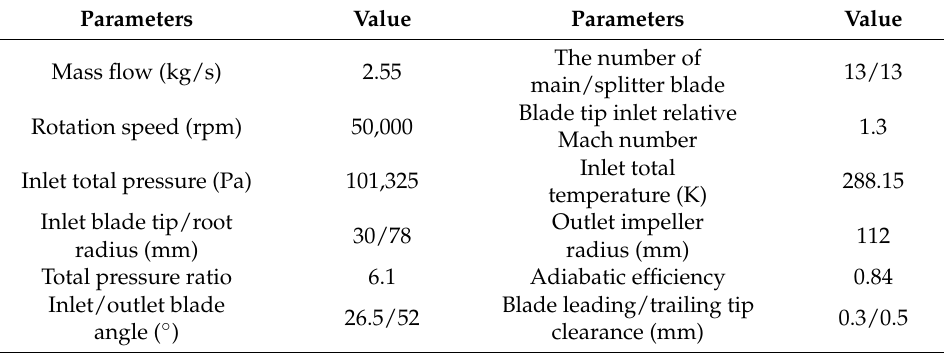
Figure 1. A schematic representation of the SRV2-O impeller. Table 1. The basic design parameters of the SRV2-O impeller.